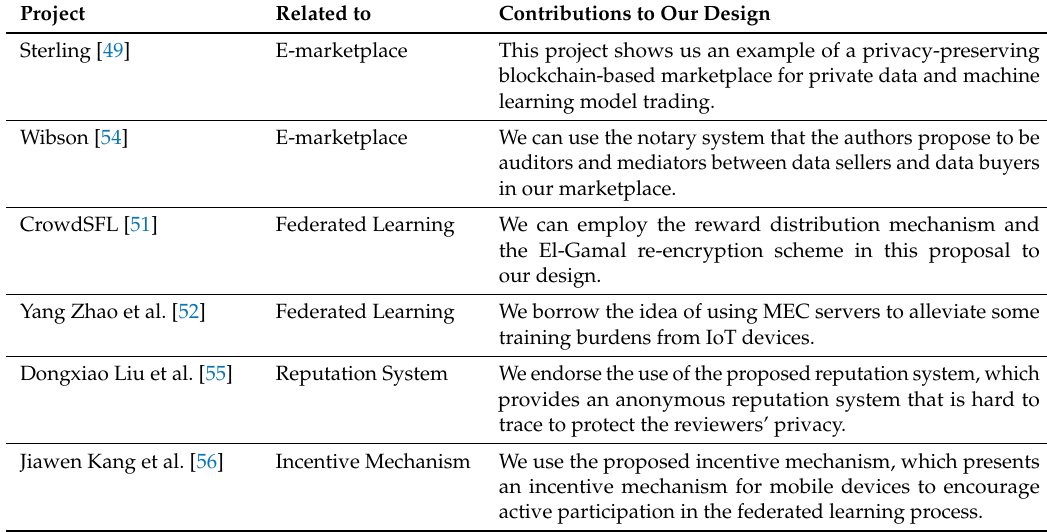
Table 6. The list of related works serving as building blocks for our data in process solutions.